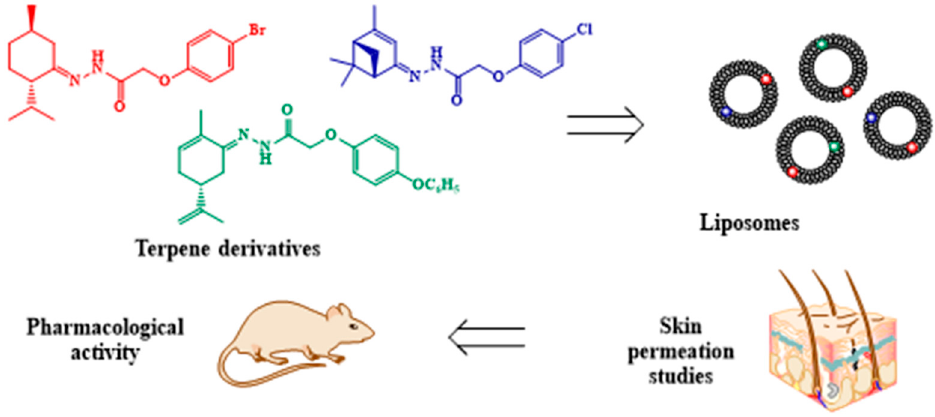
Figure 11. Terpenoid Hydrazones as Biomembrane Penetration Enhancers with Multi-Target 3.10. Aminobenzofuran-Containing Analogues of Proximicins B and C Exhibit Higher Antiproliferative Activity against Glioblastoma Cells Compared to Temozolomide in In Vitro Cellular